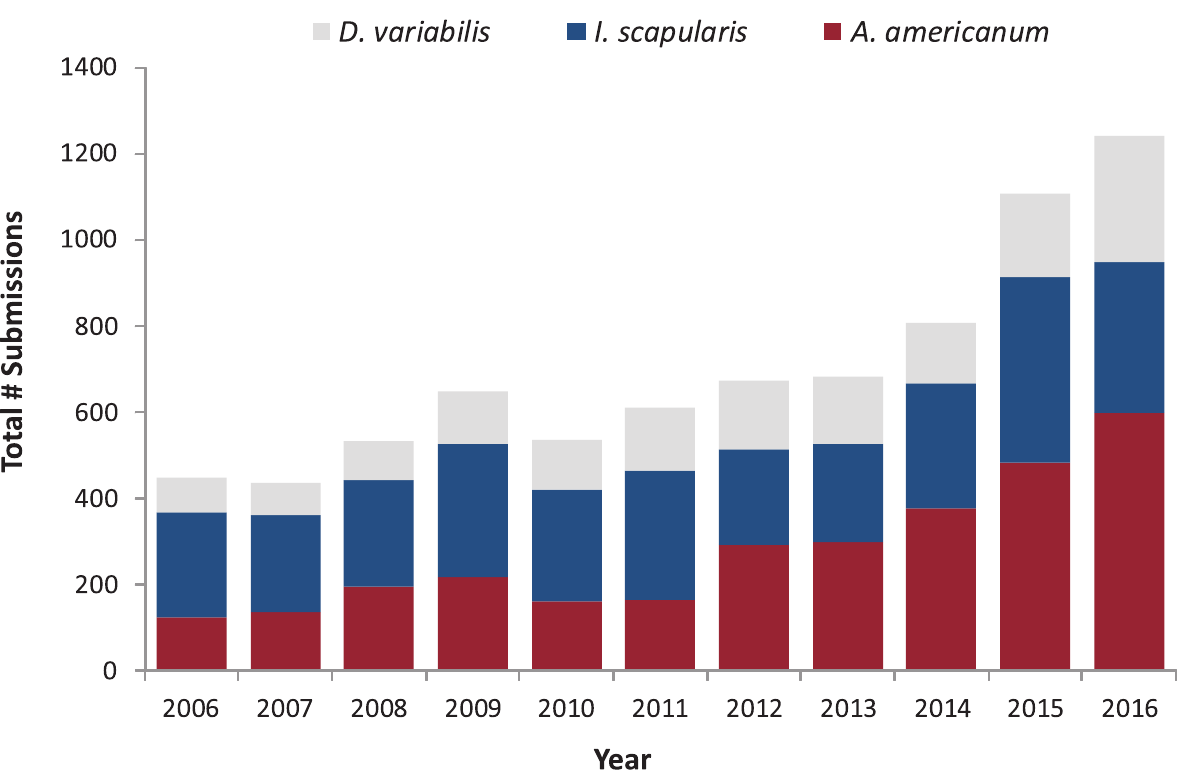
Fig 2. Total annual submissions comprising 3 medically-important tick species,